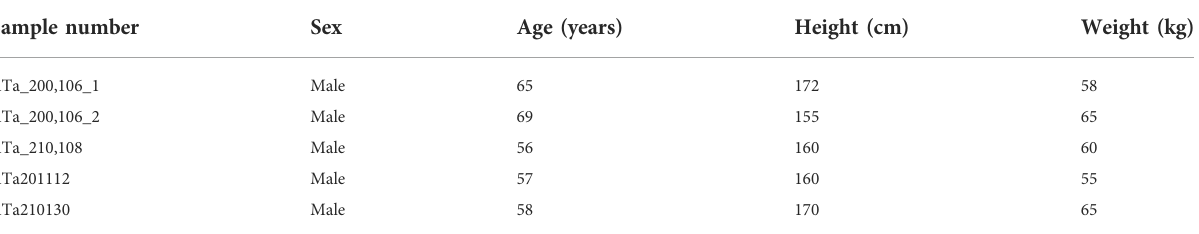
TABLE 1 Demographic characteristics for the volunteers